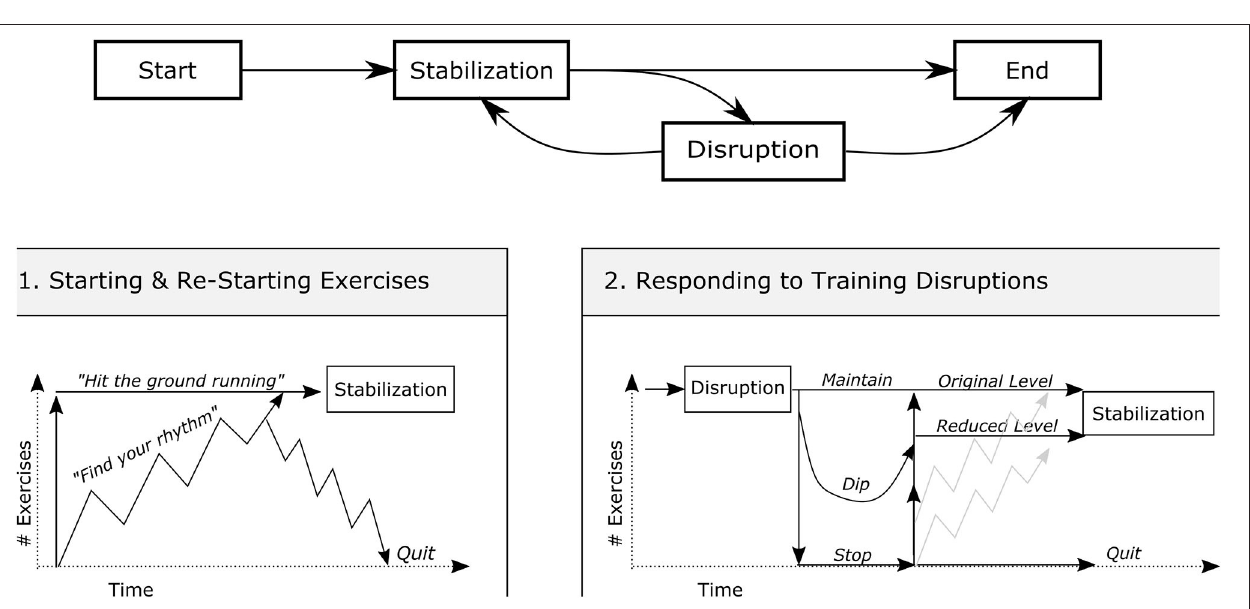
FIGURE 3 | Two phases of exercise behaviors of participants: Starting training and stabilizing (1) and managing training disruptions (2).